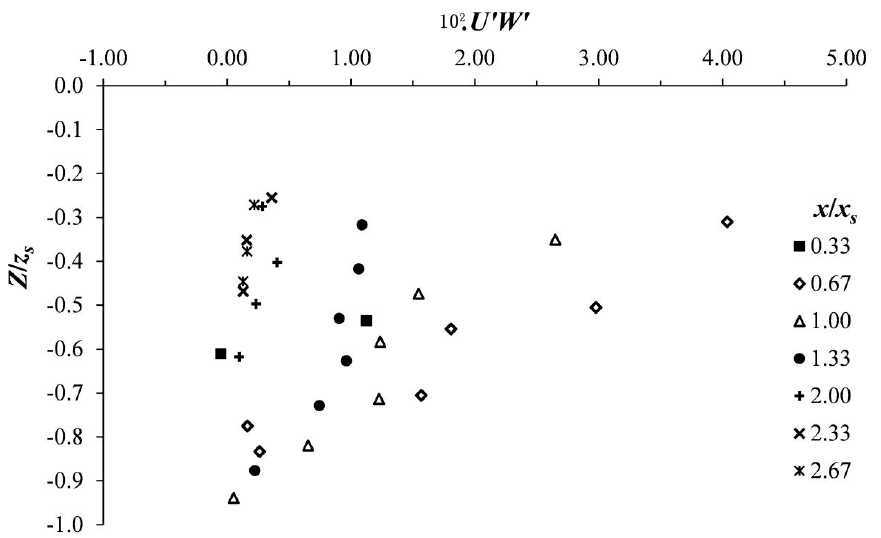
Figure 5. Vertical profiles of normalized Reynolds shear stress, U (cid:48) W (cid:48) , in scour hole and at di ff erent downstream positions x / x s along the plane of flow symmetry ( y =